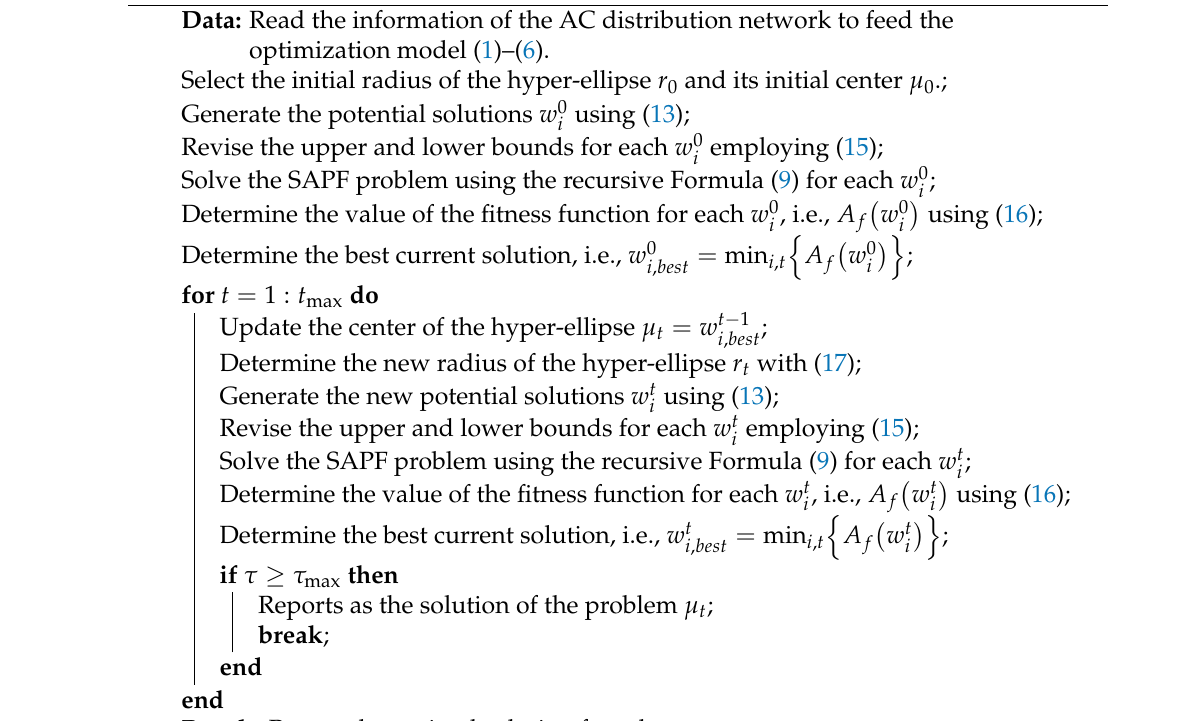
Algorithm 1: Schematic implementation of the DCVSA to optimal allocation and sizing of D-STATCOMs in electric distribution